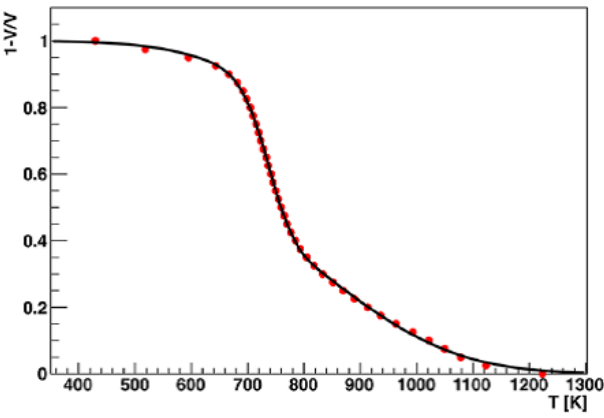
Figure 8. Comparison between experimental data (red points) and 2-DAEM fit (black line) for Sulcis coal at 100 K·min −1 .